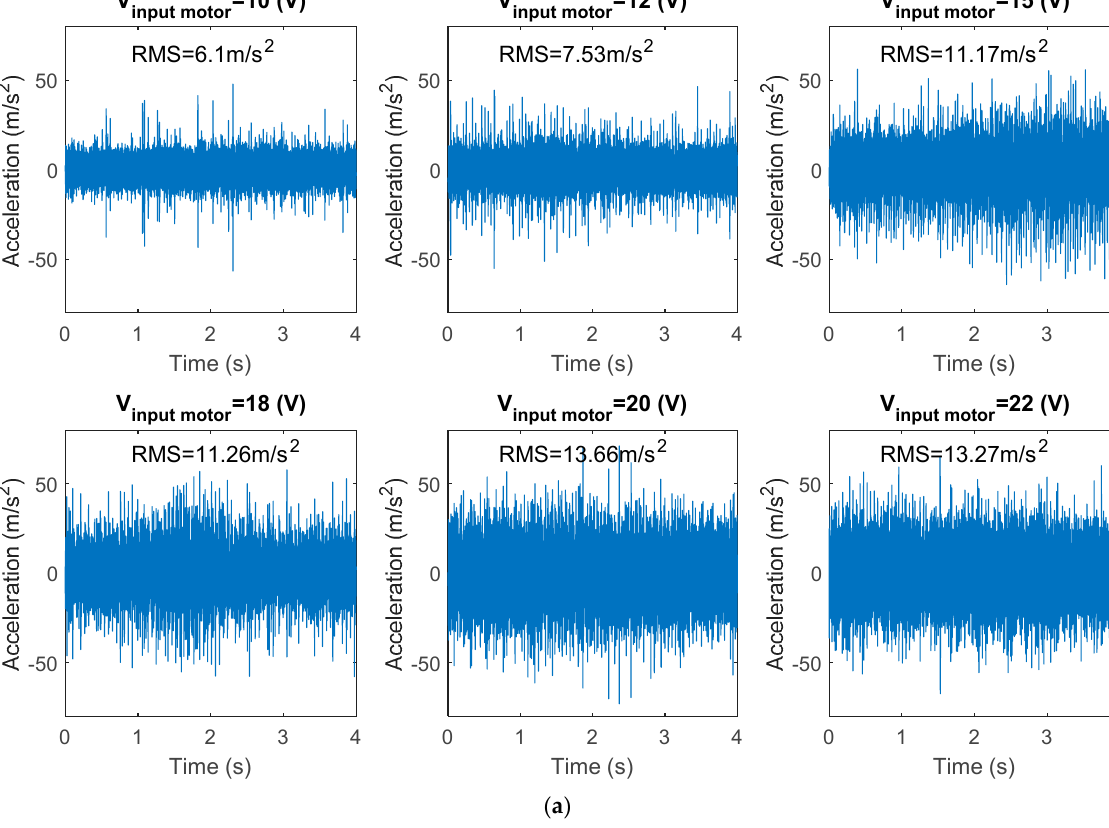
( b ) Figure 16. ( a ) The measured acceleration in the Z-direction for the shaft-misaligned DC motor, and ( b ) comparison of the acceleration in healthy and shaft-misalignment conditions. Figure 17 shows the open-circuit voltage output from the piezoelectric bimorph in the shaft-misalignment condition at different rotation speeds. As shown in Figure 17a, the time-domain voltage signals show that the voltage generation increases by increasing the rotation speed to 18.3 Hz. This trend was described in Figure 13, where the piezoelectric harvester generates the maximum power when there is a frequency match. The DC mo- tor’s voltage output in the shaft-misaligned condition is 1.9 V for 𝑓 (cid:3045) = 9.5 Hz and 10.2 V for 𝑓 (cid:3045) = 18.3 Hz. The FFT of the voltage signals, shown in Figure 17b, gives the frequency content and the resonant peaks. The first and second resonances in the FFT plot are shown in Figure 17b.